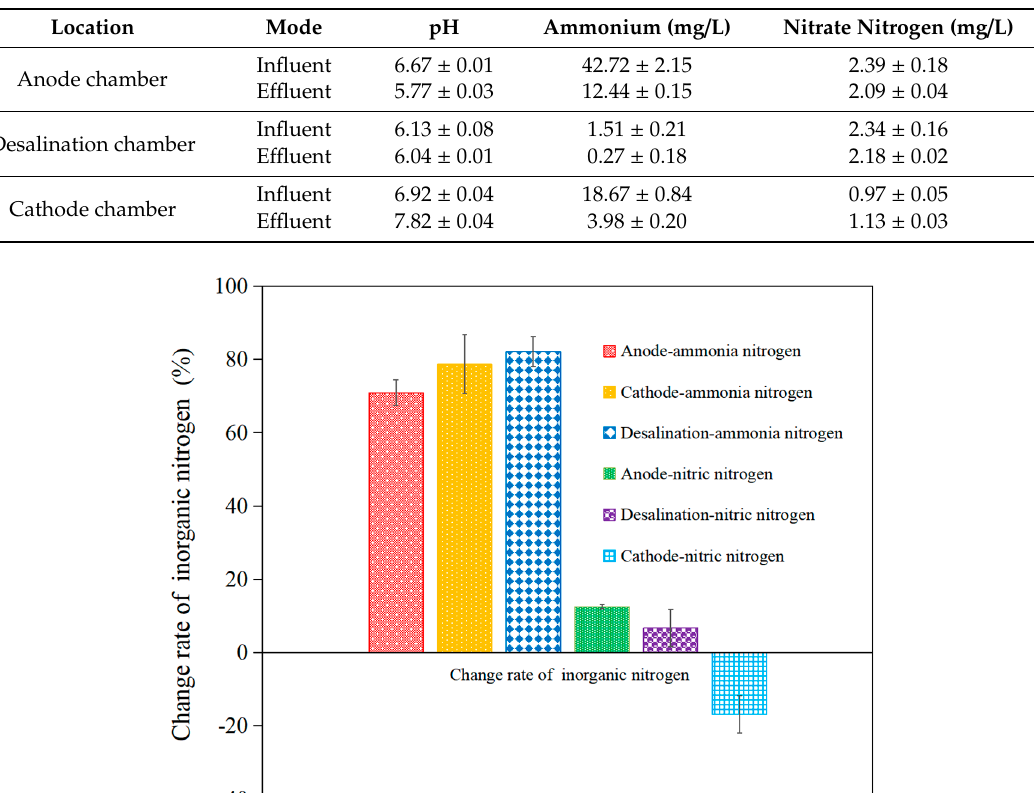
Table 1. Influent and effluent concentrations in inorganic nitrogen concentration of the AMDC.